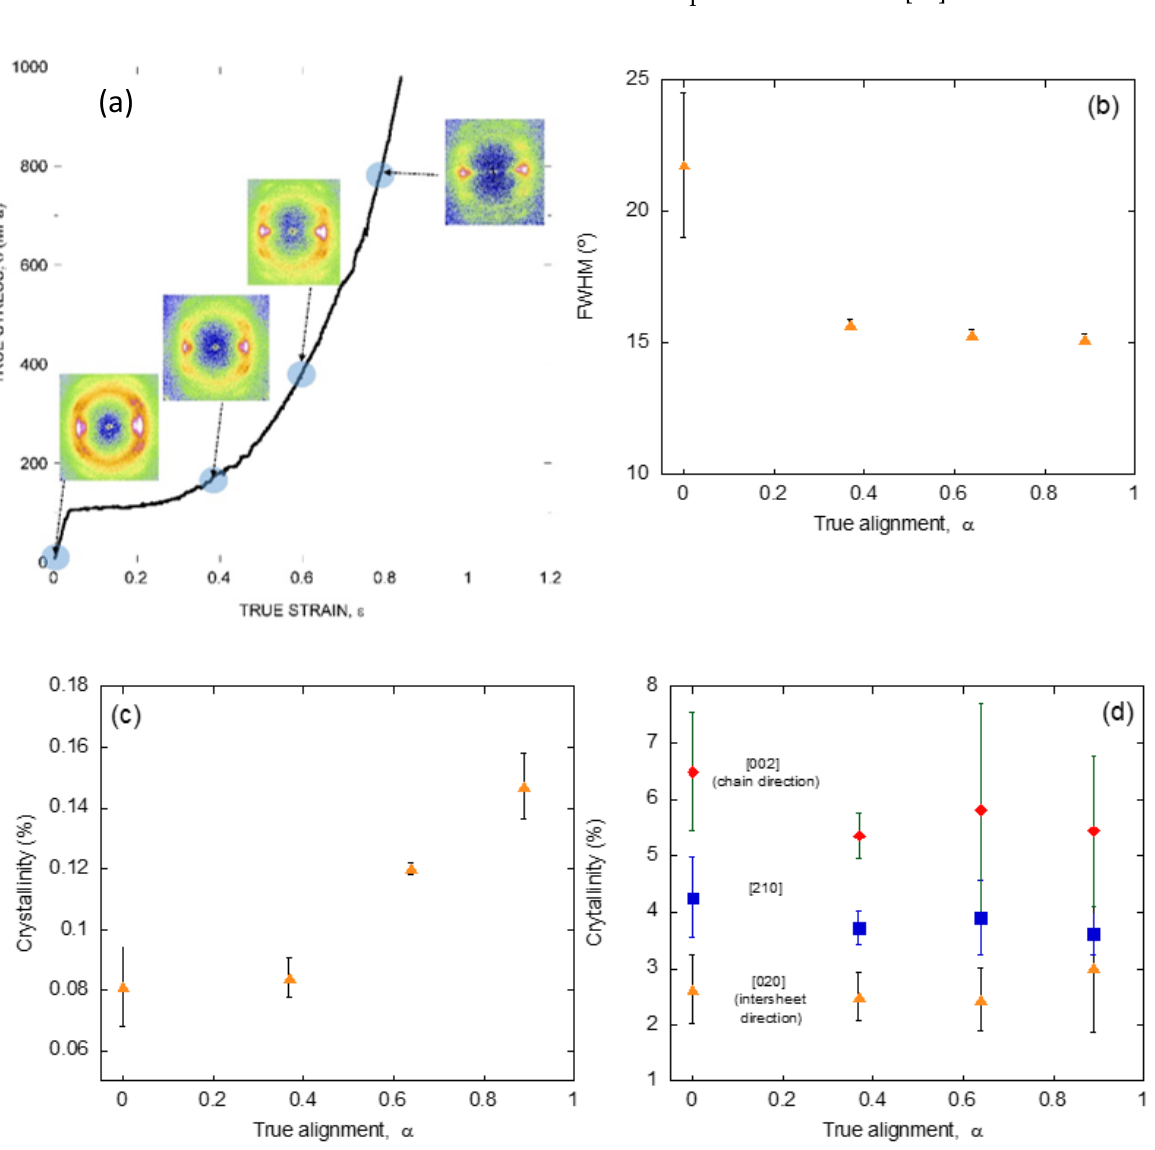
Figure 4. ( a ) X ray diffraction patterns obtained from individual Argiope trifasciata spider silk fibers subjected to different values of stretching from the maximum supercontracted state. The approximate value of the corresponding alignment parameter is indicated on an MS curve. ( b ) Evolution of the orientation of the nanocrystals with increasing values of the alignment parameter. ( c ) Evolution of the crystallinity of the fibers with increasing values of the alignment parameter. ( d ) Evolution of the size of the nanocrystals along three independent spatial directions as a function of the alignment parameter. The experimental details may be found in the corresponding references by the authors cited in the main text.